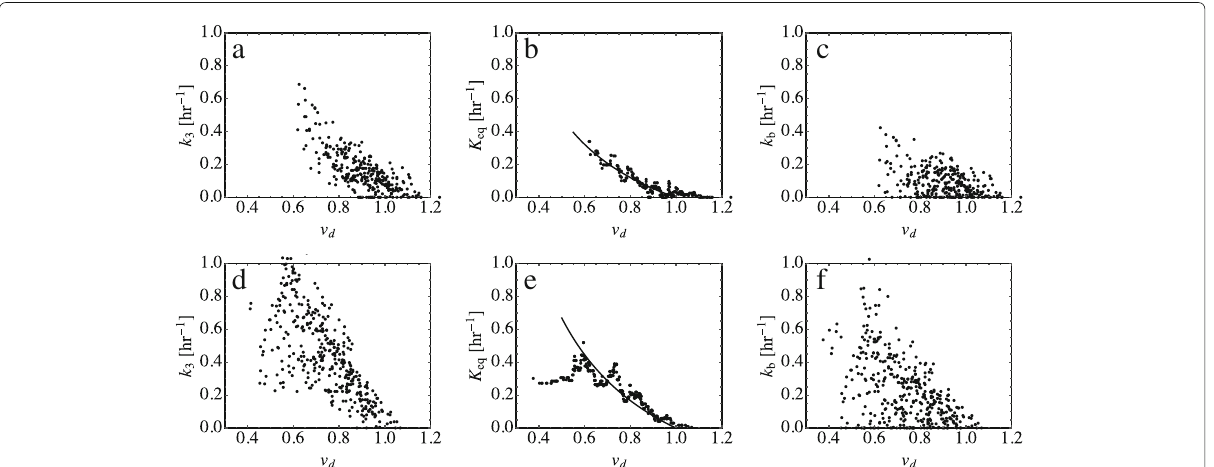
Fig. 2 Dependence of the trapping rate on tracer equilibration and binding. a and d show voxel-scale trapping rate values versus voxel-scale TBR values for patients 1 and 2, respectively. b and e show the corresponding equilibration rates, calculated from Eq. (19); the solid lines indicate fits to Eq. (18), yielding k eq = 0.45 h − 1 for pt. 1 and k eq = 0.52 h − 1 for pt. 2. ( c ) and ( f ): The voxel-scale binding rates k b calculated from Eq. (17) using the K eq values shown in b and e